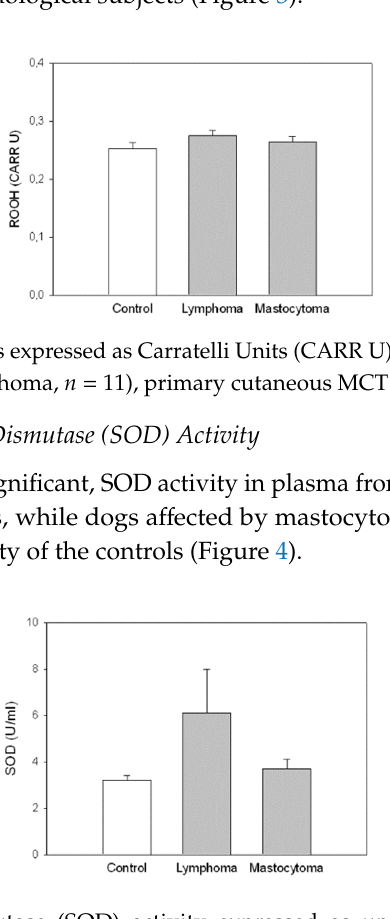
Figure 4. Superoxide dismutase (SOD) activity expressed as units / mL (U / mL). Healthy dogs (control, n = 24), multicentric lymphoma (lymphoma, n = 11), primary cutaneous MCT (mastocytoma, n =